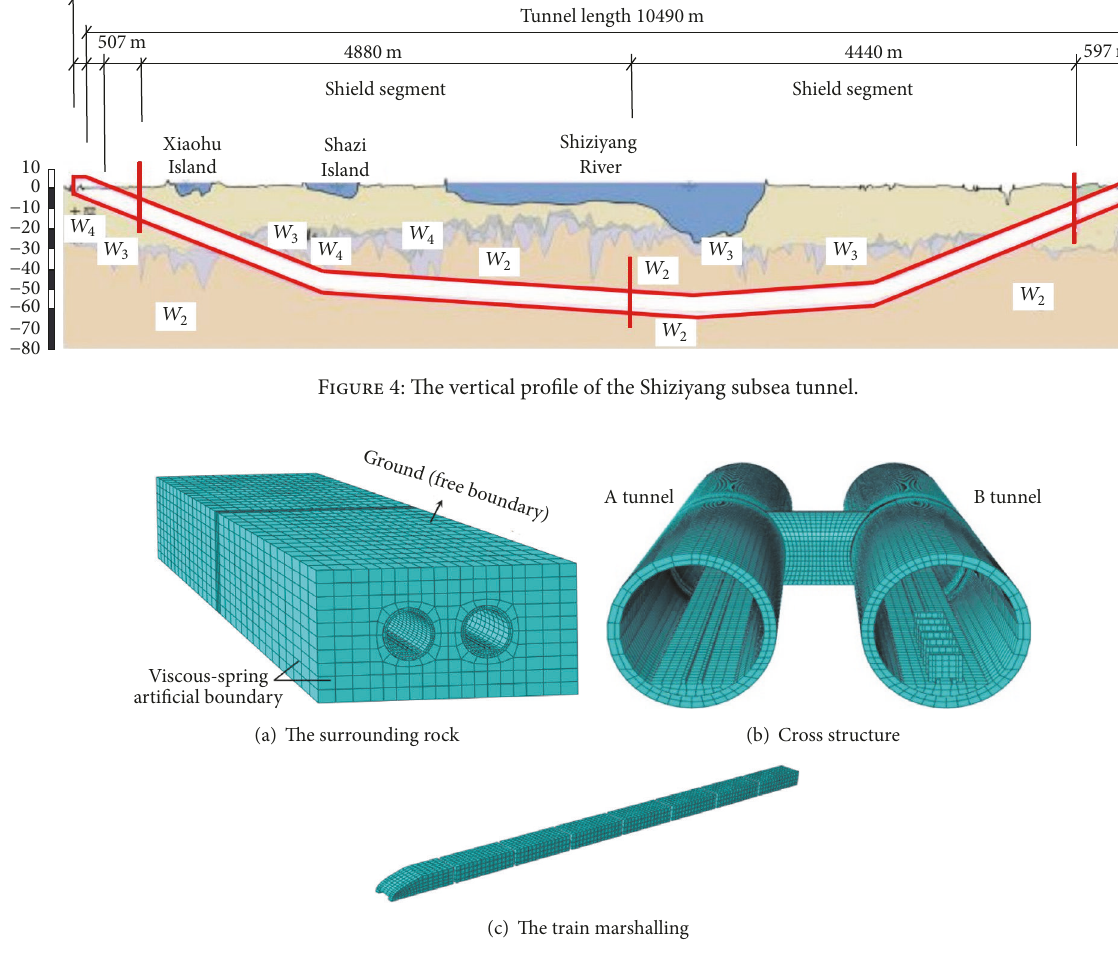
Figure 5: The model of the